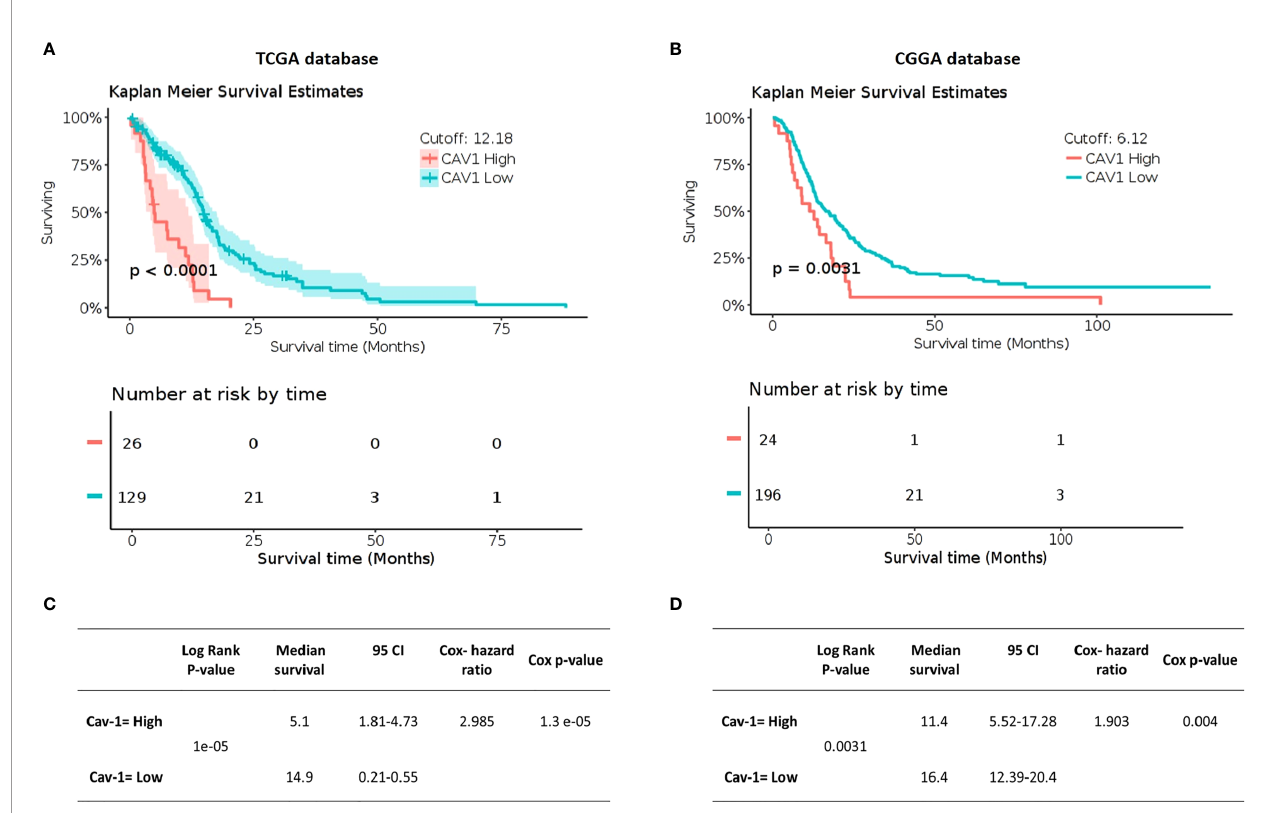
FIGURE 2 | Impact of Cav-1 expression on GB patient overall survival in TCGA (A, C) and CGGA databases (B, D) . (A, B) show respectively (TCGA and CGGA) Kaplan Meier survival curves for GB patients where the tumours displayed either high or low expression of Cav-1 (separated by a mRNA cut point of 12.18 and 6.12 respectively). The survival curves are supported by the corresponding patient numbers at risk by each timepoint (shown below the respective KM curve). (C, D) show respectively, (TCGA and CGGA) Univariate Cox regression analysis for Cav-1 expression and the associated GB cohort including the 95% con fi dence interval (CI), median survival in months. Cox Hazard ratio and the